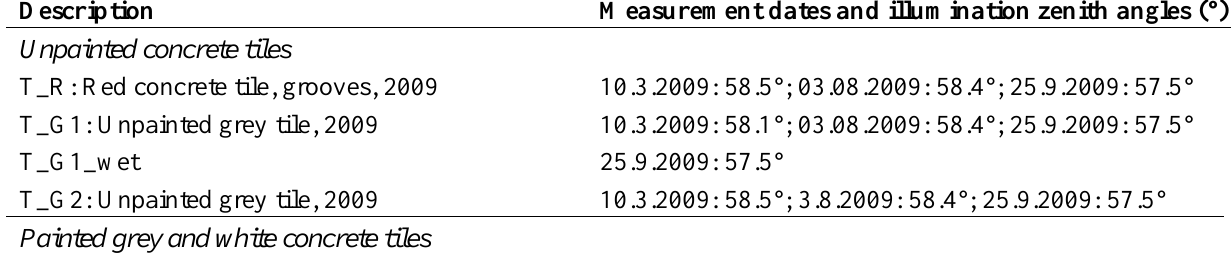
Description Measurement dates and illumination zenith angles